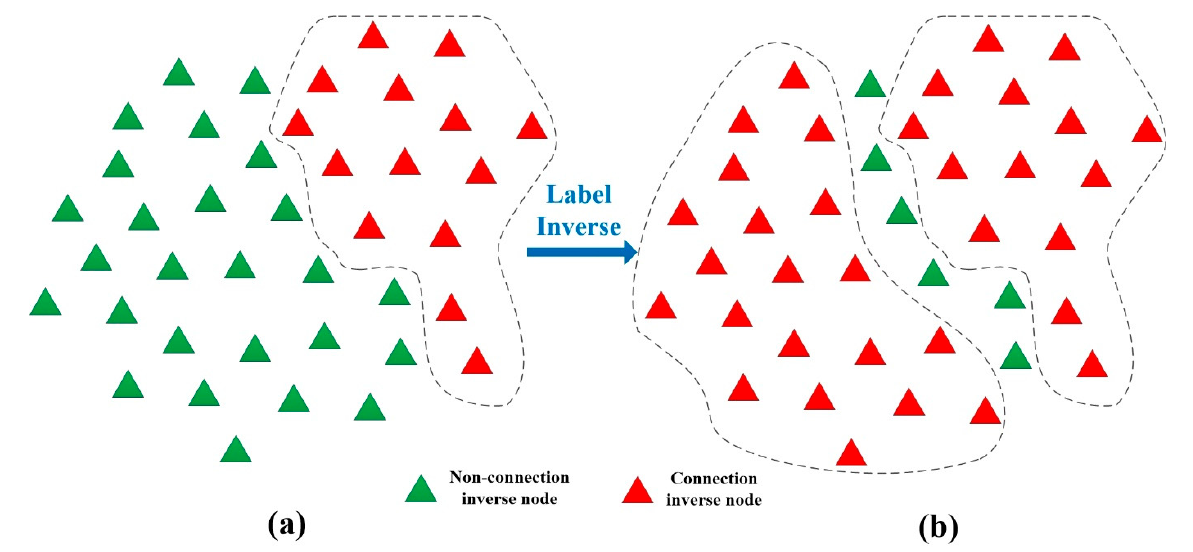
Figure 3. Explanation of inverse label operation. ( a ) Before inverse label operation. ( b ) After inverse label operation.